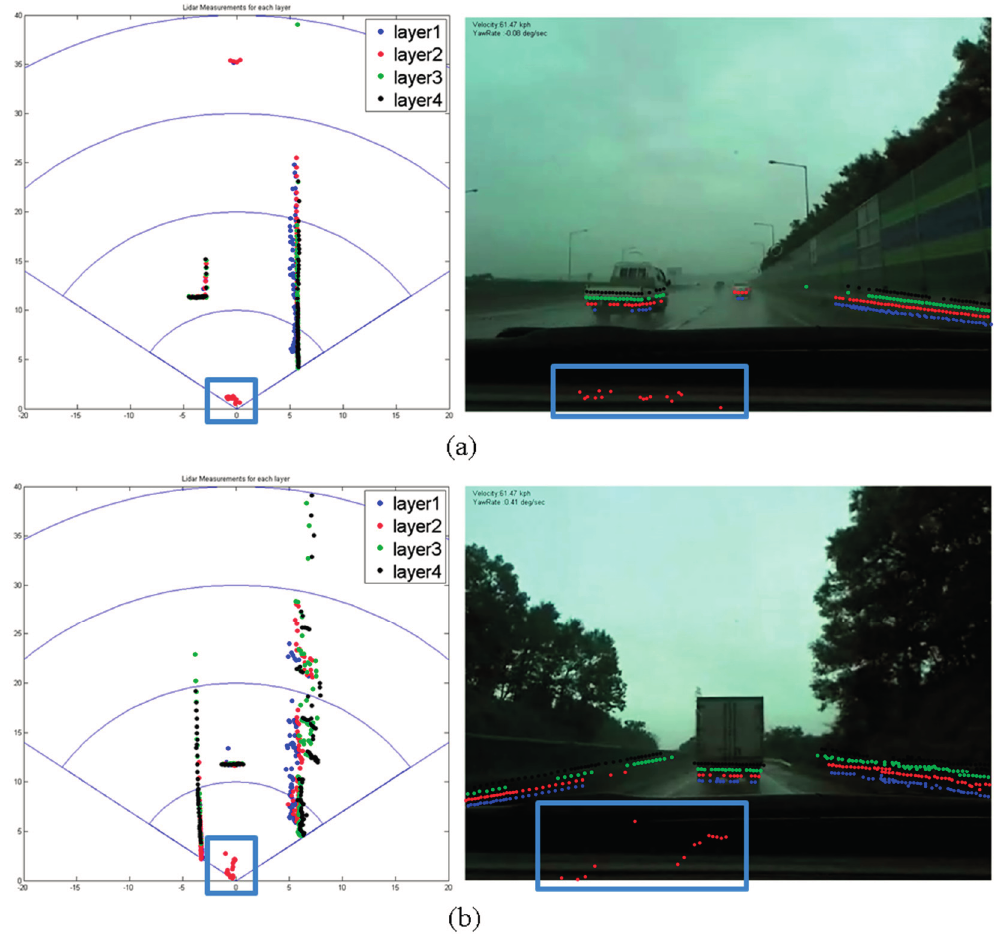
Figure 8. A ghost caused by moisture. ( a ) rainy weather ( b ) foggy